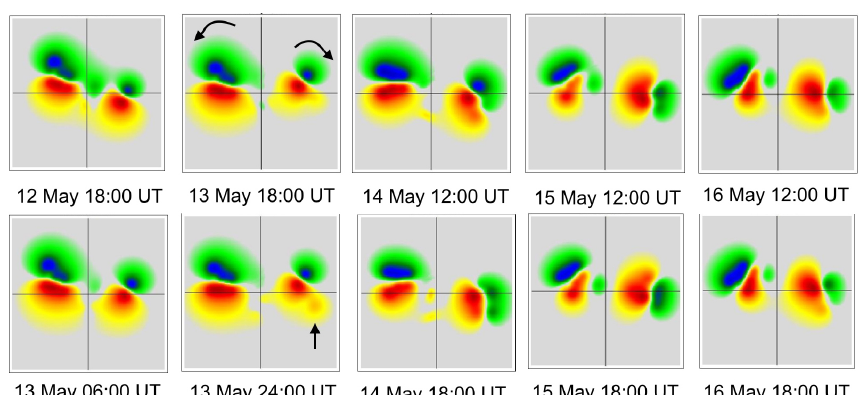
Figure 8. Simulated magnetograms from 12–16 May 1921. On 13 May the active regions start to rotate and new flux emerges.